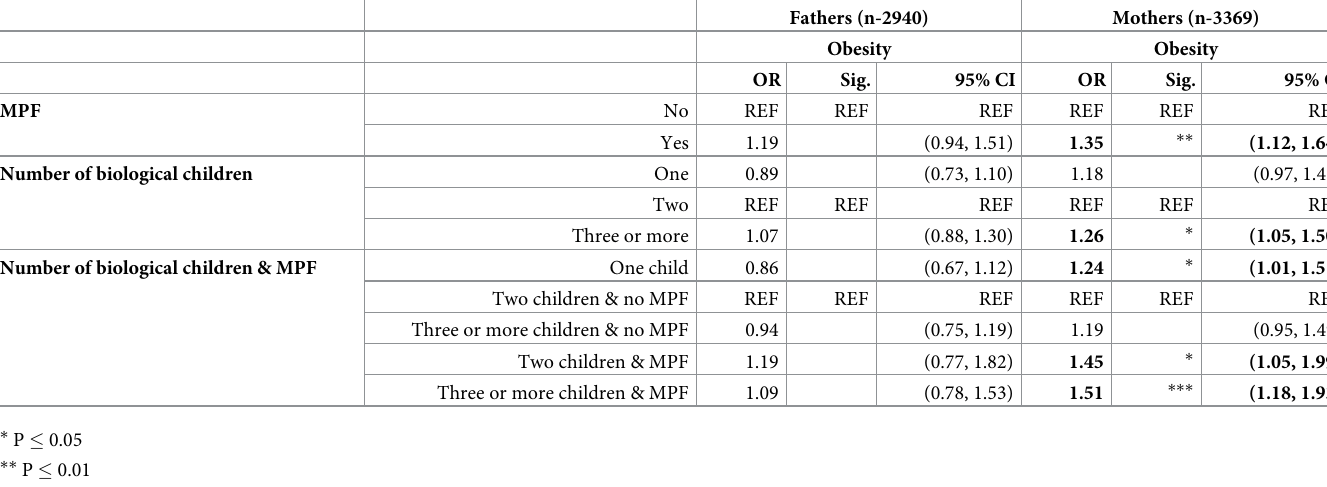
Table 2. Odds ratios from logistic regression models estimating the unadjusted associations between MPF, number of children and obesity odds for mothers and